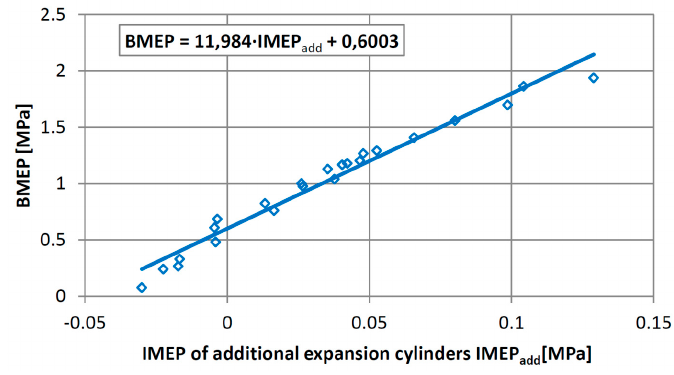
Figure 12. The Brake Mean Effective Pressure of the five ‐ stroke engine as a function of the Indicated Mean Effective Pressure of the additional expansion cylinders.